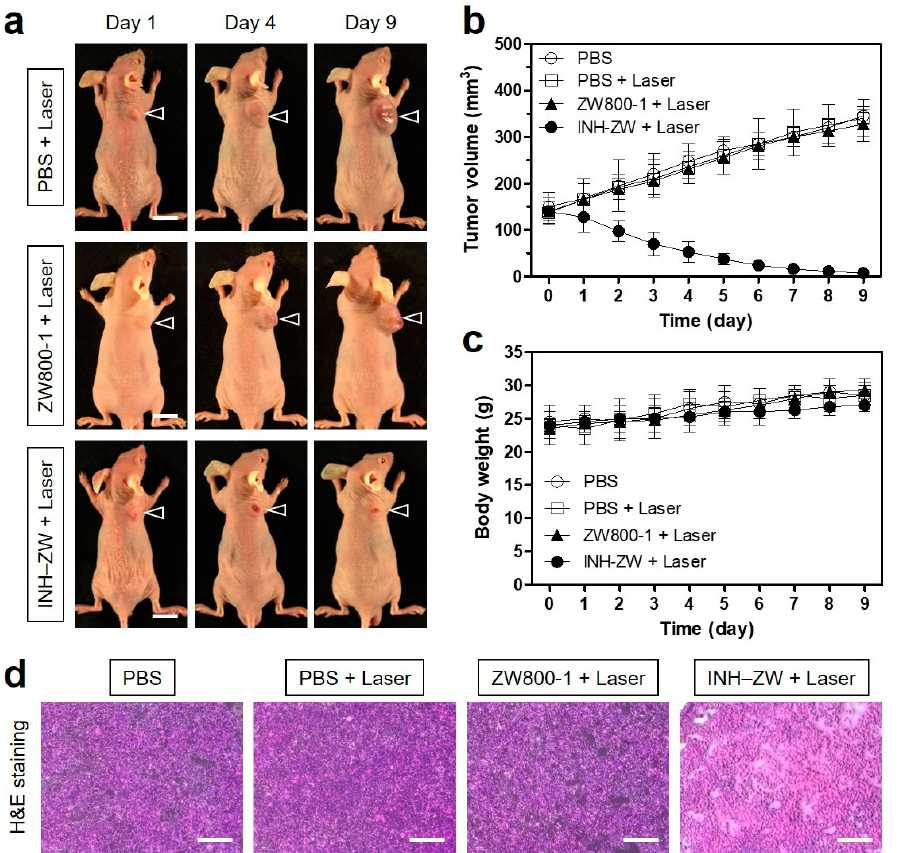
Figure 7. In vivo NIR phototherapeutic efficacy. ( a ) Representative photos of tumor size changes in HT-29 tumor-bearing mice for 9 days after different treatments. The laser groups were treated with 1 h post injections of PBS, ZW800-1, and INH–ZW, followed by 808 nm laser irradiation (1.1 W/cm 2 ) for 5 min. The tumor sites are indicated by arrowheads. Scale bars = 1 cm. ( b ) Tumor growth rates and ( c ) body weights of each treatment group were monitored for 9 days. Data are expressed as the mean ± S.D. of three independent experiments. ( d ) Tumor sections stained with H&E from each group after 24 h of different treatments. Scale bars = 100 μ m.